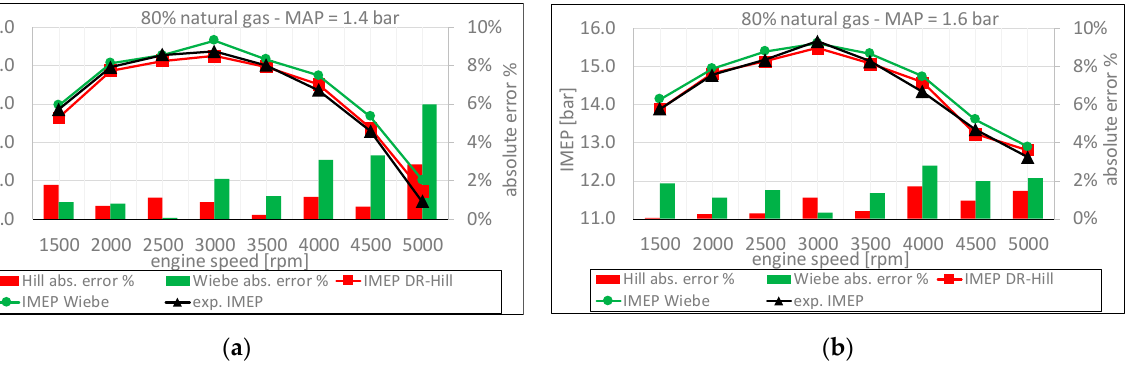
Figure 7. comparison between the experimental and simulated IMEP; 80% NG fuel mixture. ( a ) Figure 7. Comparison between the experimental and simulated IMEP; 80% NG fuel mixture. MAP = 1.4 bar; ( b ) MAP = 1.6 bar. MAP = 1.4 bar; ( b ) MAP = 1.6 bar. ( a ) MAP = 1.4 bar; ( b ) MAP = 1.6 bar.